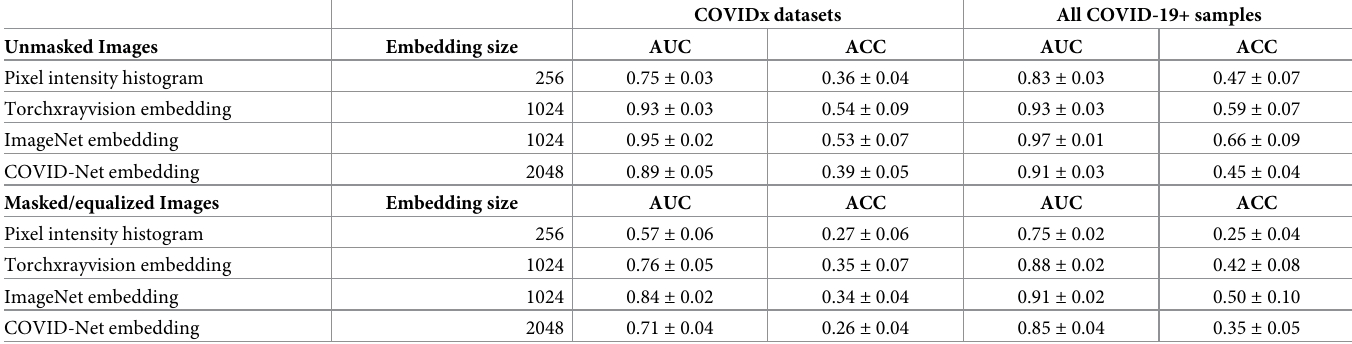
Table 2. Results showing how well logistic regression classifiers can identify which sub-dataset a CXR is from within the COVIDx dataset, and how well classifiers can identify which dataset a “COVID-19+” CXR is from across both the COVIDx and CC-CCII datasets. We report AUC values as averages of the one-vs-all binary AUCs between all classes, and accuracy (ACC) as the average accuracy over all classes. We observe that the representations generated by the classifiers, even from masked/ equalized inputs, contain enough information to accurately identify the sources of the imagery in both